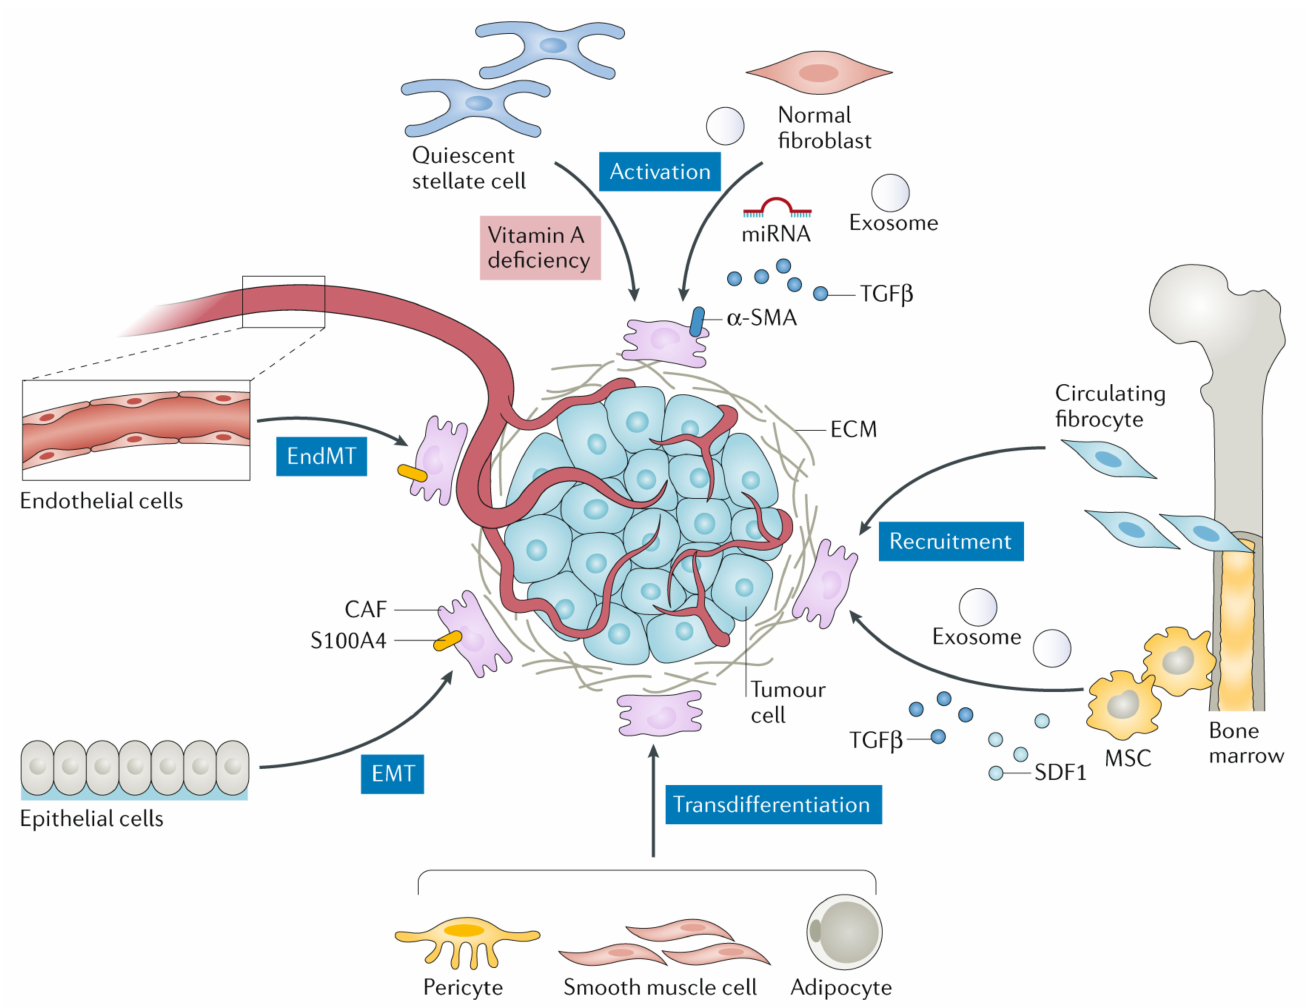
Figure 3. Potential cellular sources and biological processes involved in CAF formation. CAFs can be generated from normal resident fibroblasts (by activation), endothelial cells (by EndMT), epithelial cells (by EMT), pericyte/smooth muscle cell/adipocyte (by transdifferentiation), and circulating fibrocytes (by recruitment). EndMT is known as endothelial- to-mesenchymal transition, EMT as epithelial-to-mesenchymal transition, SDF1 as stromal-derived factor 1, S100A4 as fibroblast-specific protein 1, MSC as mesenchymal stem cell, TGF β as transforming growth factor- β , and α -SMA as α -smooth muscle actin. The figure is reproduced with permission from